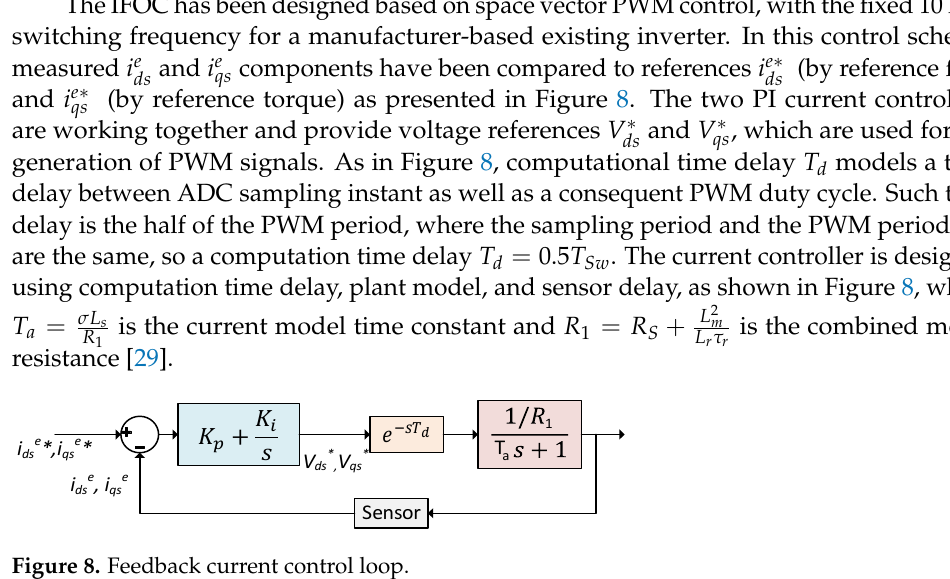
Figure 7. Feedback flux control loop.